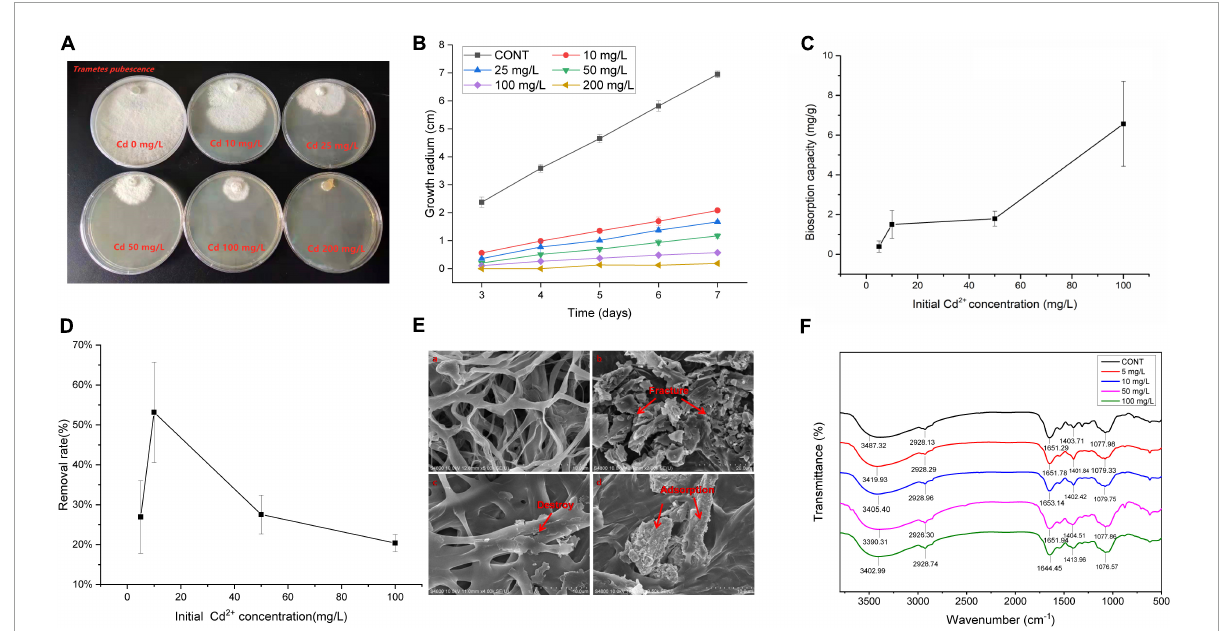
FIGURE1 Effects of cadmium exposure in T. pubescens and its cadmium removal capacity. (A) T. pubescens growth on PDA amended with different concentrations of Cd 2 + for 7 days. (B) Growth inhibition of T. pubescens with varying Cd 2 + concentrations (0–200 mg/L). (C) Biosorption capacity of T. pubescens in different concentrations of Cd 2 + for 7 days exposure. (D) The removal rate of T. pubescens in different concentrations of Cd 2 + for 7 days exposure. (E) SEM micrograph of T. pubescens biomass under Cd 2 + stress (a): without Cd 2 + treatment (CONT); (b): treated with 100 mg/L of Cd 2 + ; (c,d): treated with 10 mg/L of Cd 2 + after 7 days exposure. (F) FTIR spectra of T. pubescens grown for 7 days in a Cd-free medium and the presence of Cd ions (initial concentration: 0 mg/L, 5 mg/L, 10 mg/L, 50 mg/L, 100 mg/L). CONT, no Cd treatment